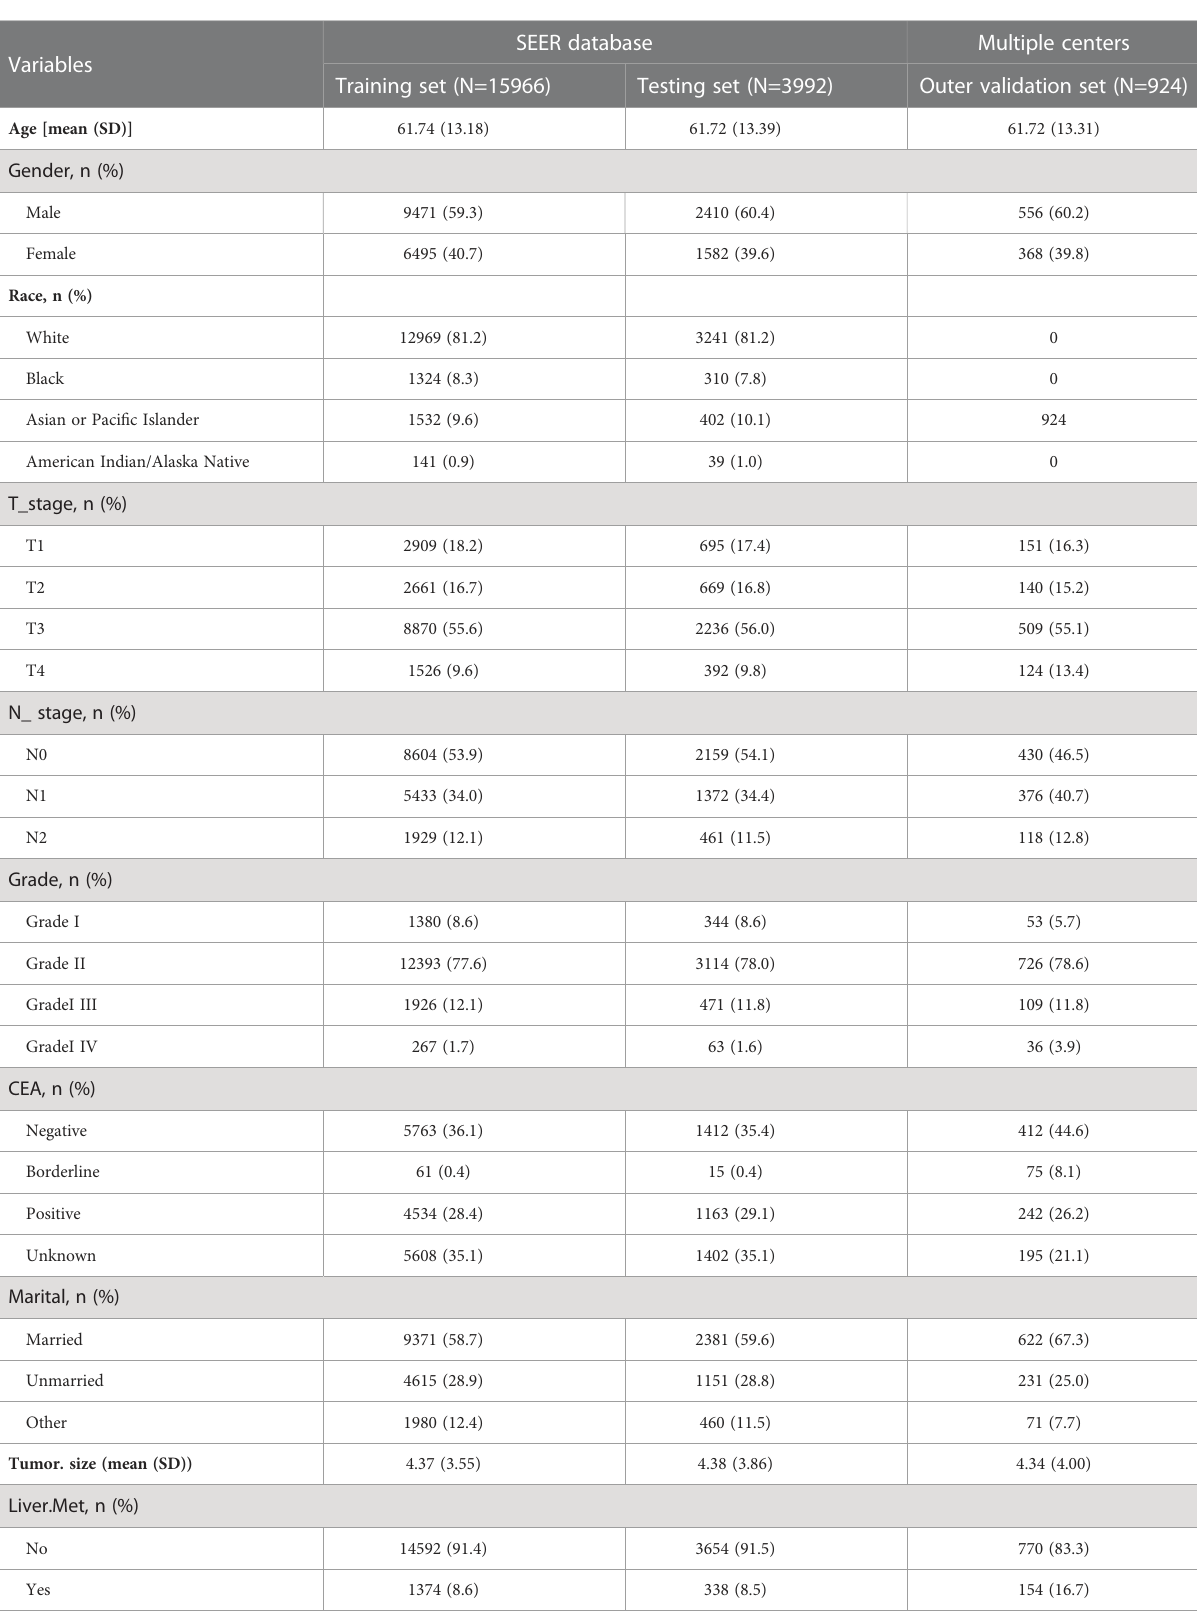
TABLE 1 Clinical baseline features of SEER and multiple centers hospital